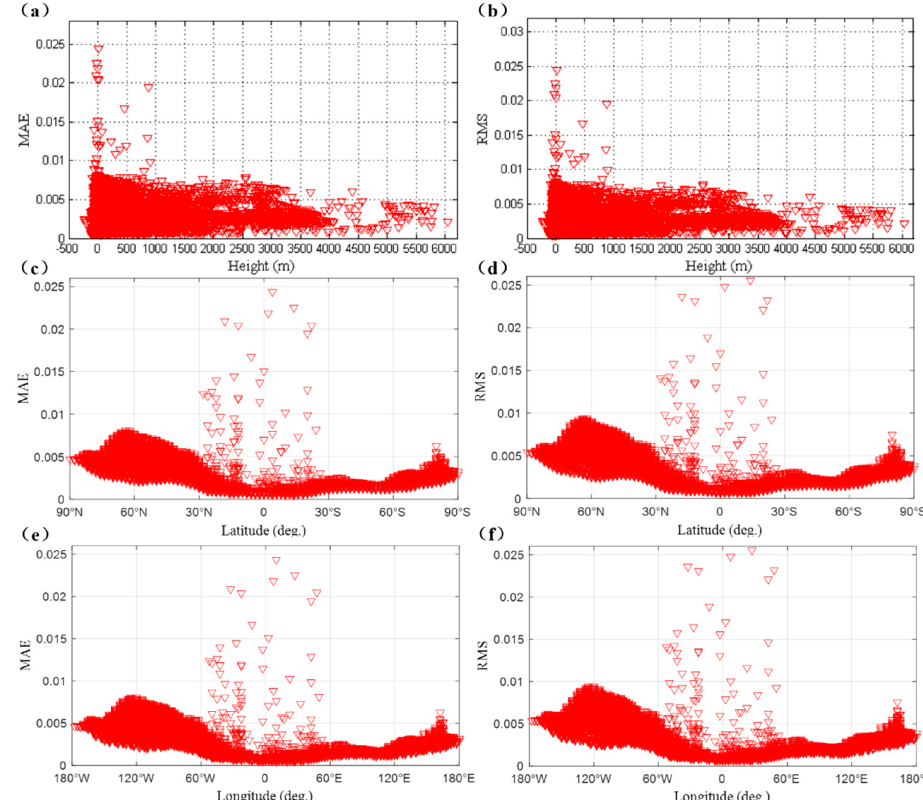
Figure 10. Distribution of the MAE and RMS with respect to height, latitude, and longitude in 2004, where ( a ) and ( b ) refer to the MAE and RMS with height, ( c ) and ( d) are the MAE and RMS with the latitude while the ( e ) and ( f ) represent the MAE and RMS with longitude, respectively.